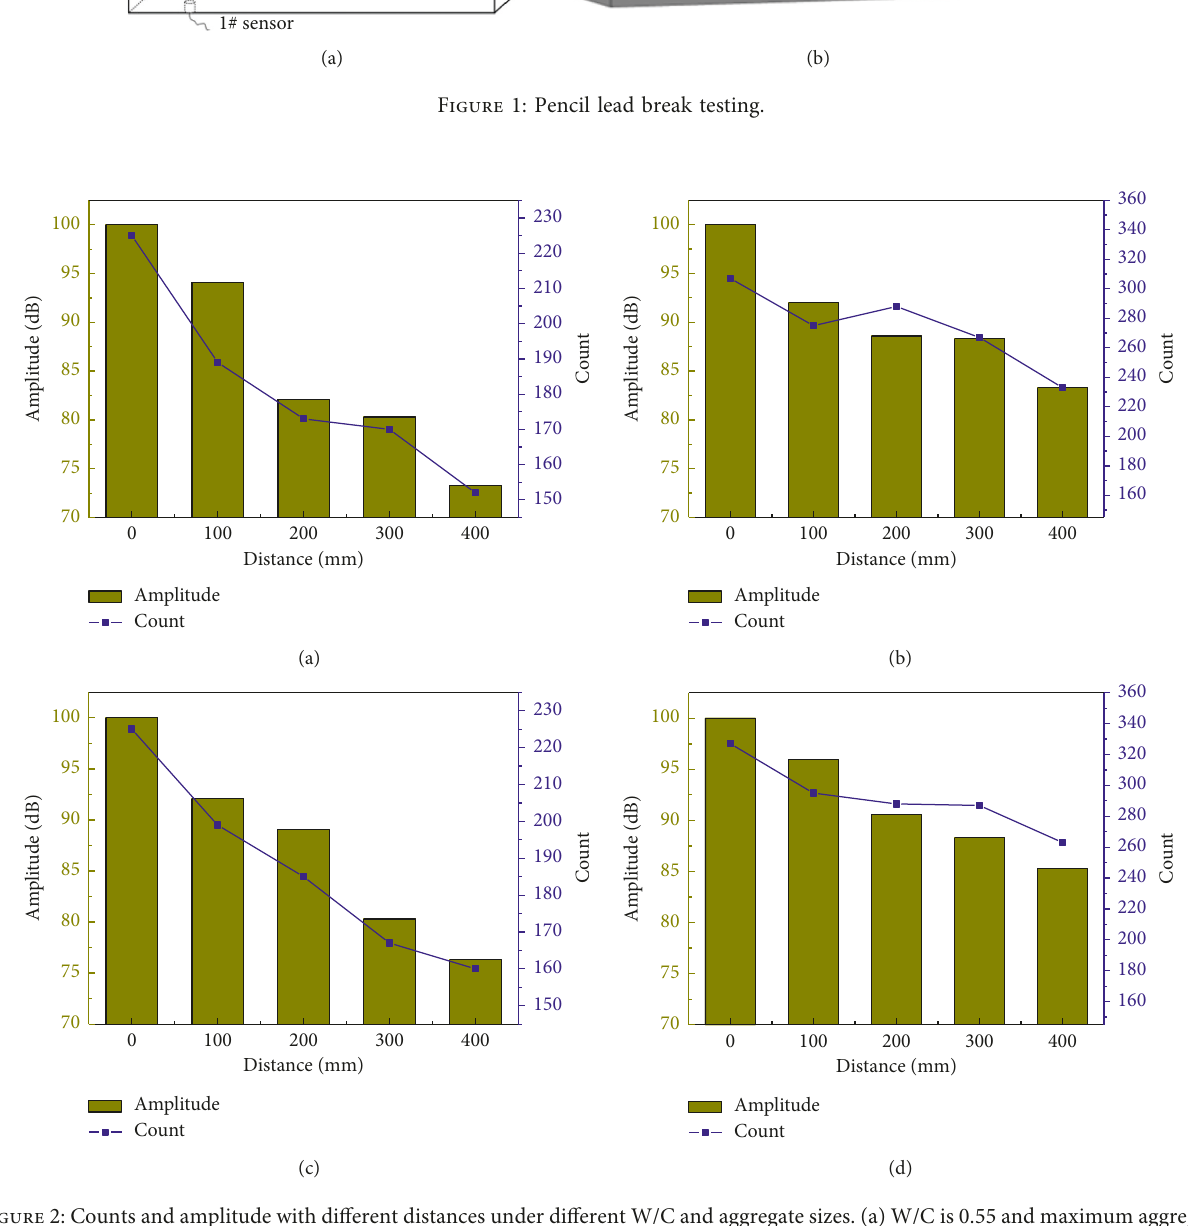
Figure 2: Counts and amplitude with different distances under different W/C and aggregate sizes. (a) W/C is 0.55 and maximum aggregate size is 25mm; (b) W/C is 0.55 and maximum aggregate size is 4.75mm; (c) W/C is 0.4 and maximum aggregate size is 25mm; (d) W/C is 0.7 and maximum aggregate size is 4.75mm.